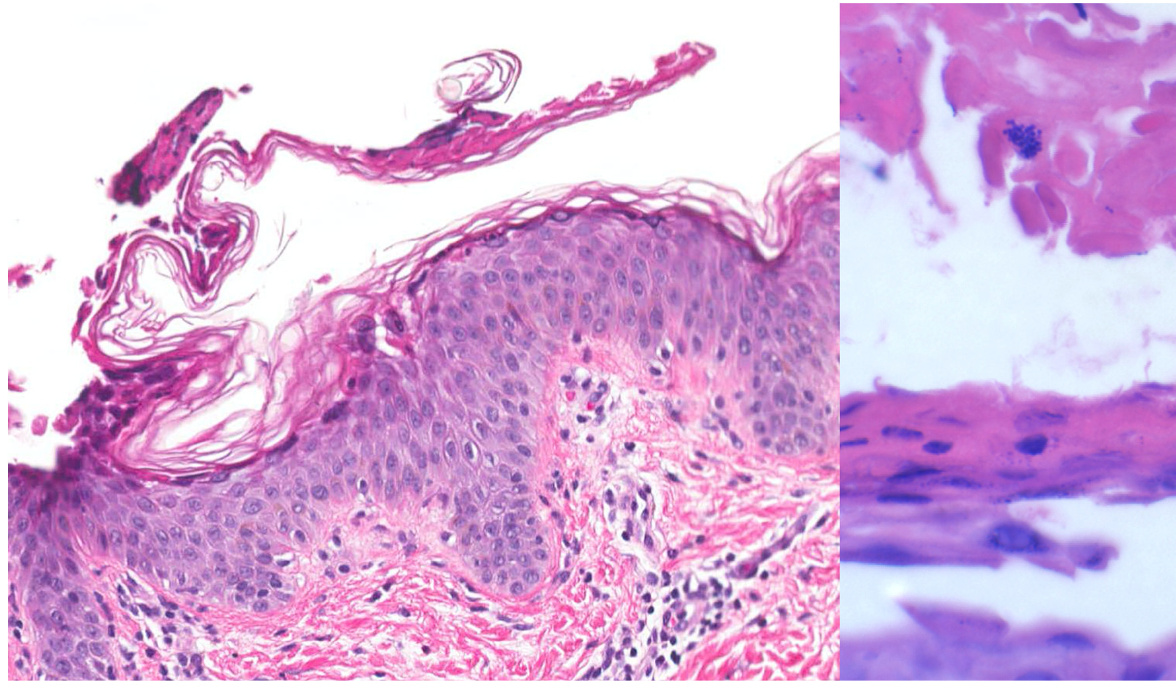
Figure 4. Bullous impetigo. Subcorneal acantholysis (left, H&E, 200x magnification) and cocci in clusters within the stratum corneum (right, H&E, 600× magnification). Original image provided by Kiran Motaparthi, MD.